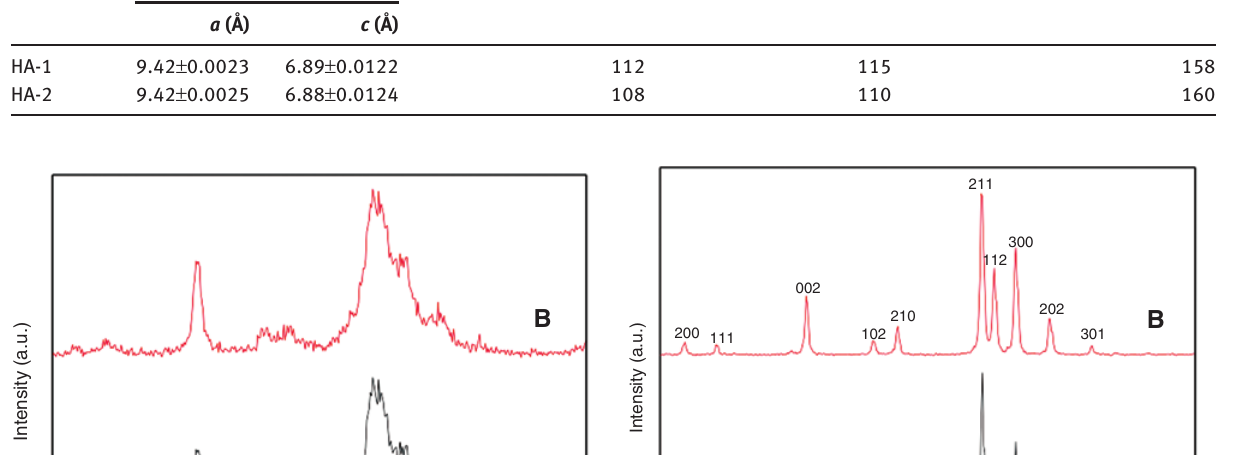
Table 1: Lattice parameters, crystalline size, particle size and hydrodynamic diameter of nanosized hydroxyapatite particles. Sample ID